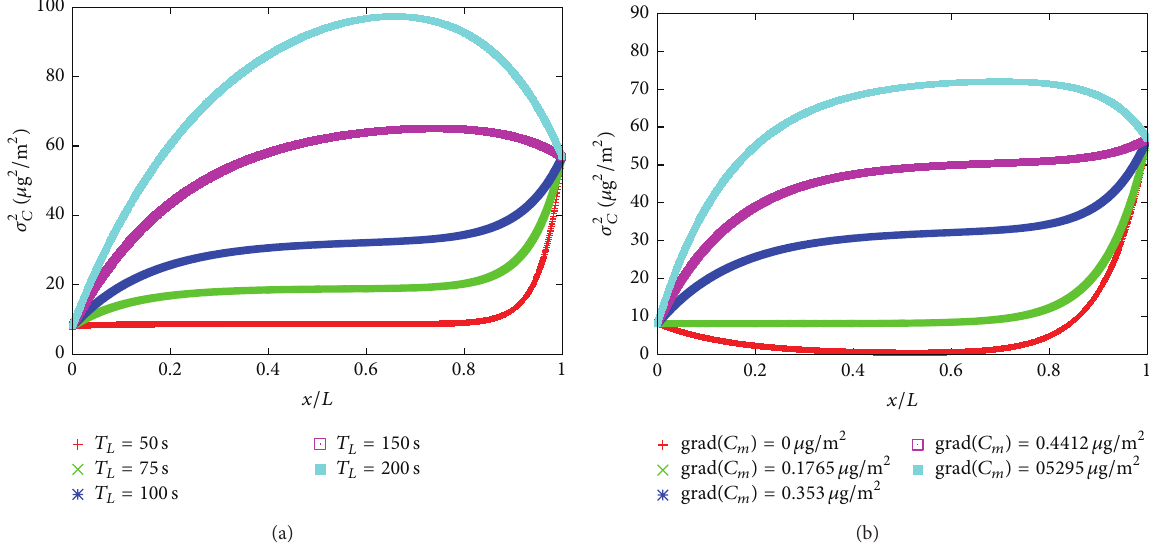
Figure 5: (a) Reference dimensional solution (but 𝑟 = 0.001 /s) with sensitivity analysis on the Lagrangian integral time scale, which is alternatively equal to 50 s (+), 75s ( × ), 100 s ( ∗ ), 150 s ( ◻ ), or 200 s ( ◼ )— 𝜎 2 𝐶, 115 𝜇 g 2 /m 2 , respectively. (b) Reference dimensional solution (but 𝑟 = 0.001 /s) with sensitivity analysis on the scalar mean gradient, which is alternatively equal to 0 𝜇 g/m 2 (+), 0.1765 𝜇 g/m 2 ( × ), 0.353 𝜇 g/m 2 ( ∗ ), 0.44125 𝜇 g/m 2 ( ◻ ), or 0.5295 𝜇 g/m 2 ( ◼ )— 𝜎 2 𝐶, 32.507 𝜇 g 2 /m 2 , 50.79 𝜇 g 2 /m 2 , and 73.14 𝜇 g 2 /m 2 ,